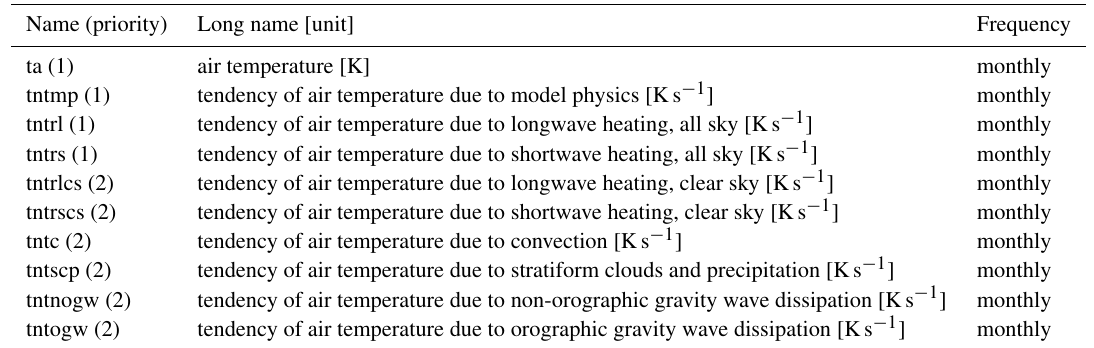
Table 5. Heat (atmosphere). 2-D zonal mean variables (2-D grid: YZT) on the plev39 grid. The zonal mean temperature is requested, as it would otherwise be unavailable at this vertical